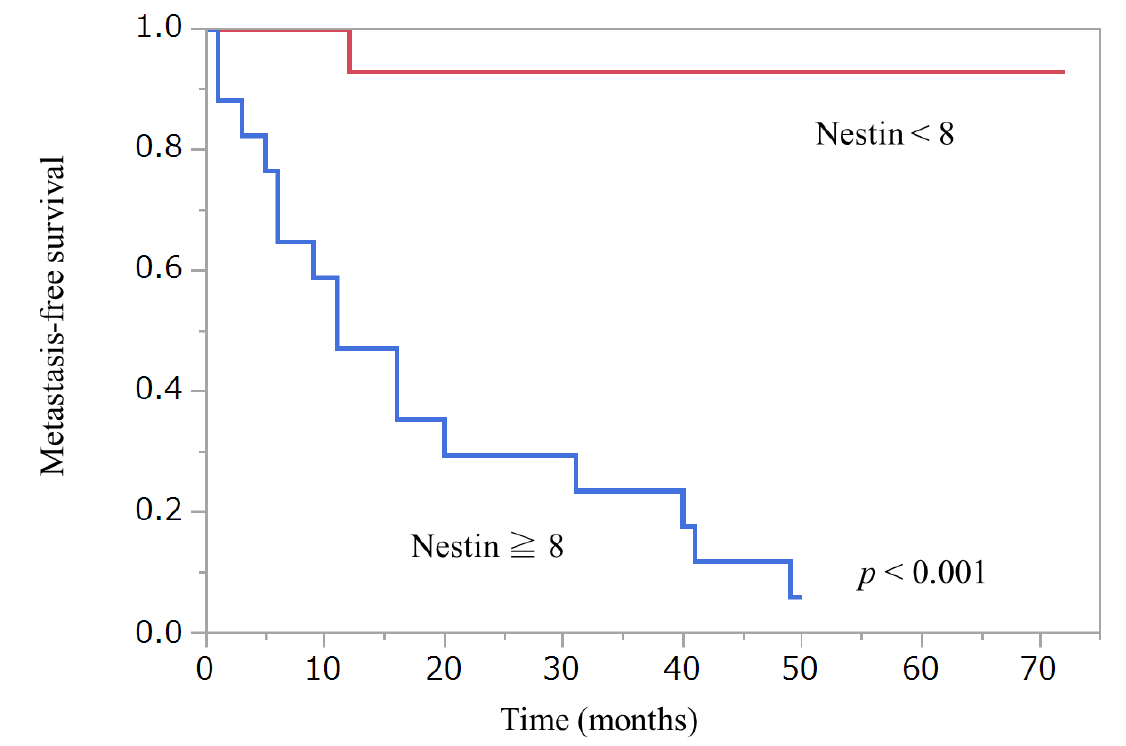
Figure 3. Kaplan–Meier curve and recurrence-free survival distribution between Nestin and matastasis.